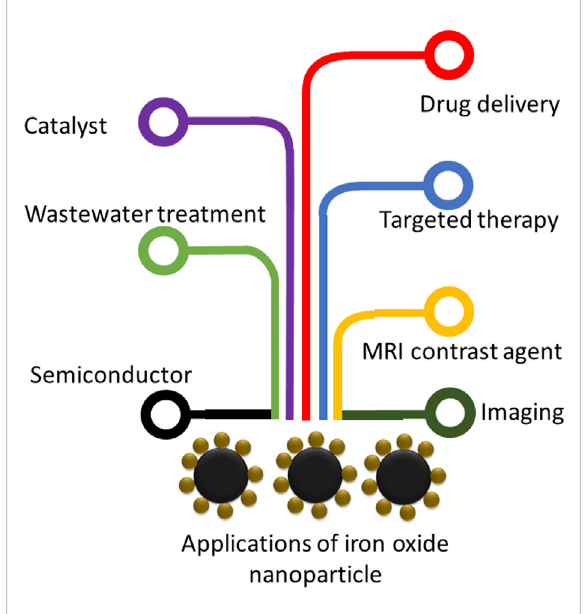
FIGURE 3 Potential applications of IONPs. A wide range of practical applications are